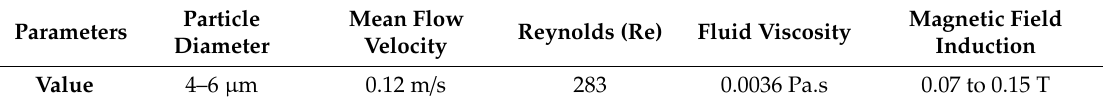
Table 5. Particle deposition parameter setup.